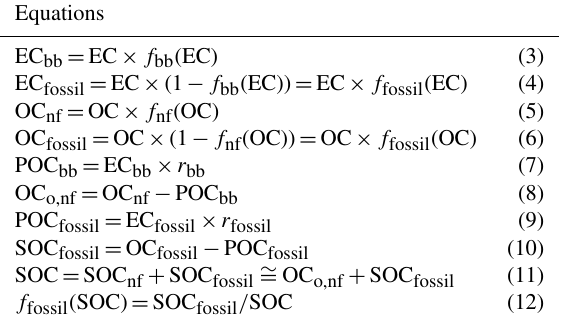
Table 1. Equations for 14 C source apportionment of EC and OC. See Sect. 2.4 for details. Respectively, r bb and r fossil are the primary OC / EC ratio for biomass burning and fossil fuel combustion. The estimation of r bb and r fossil is presented in Supplement Sect. S2.